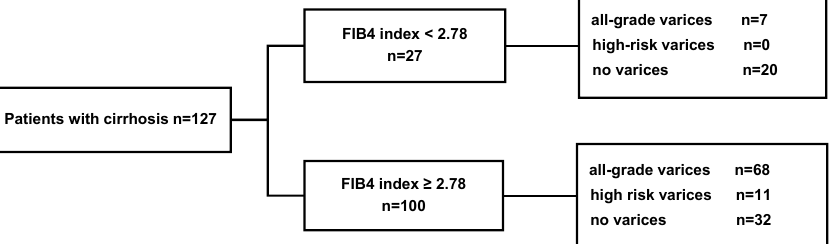
Figure 2. Rates of all-grade varices and high-risk varices according to a FIB-4 cuto ff of 2.78 in the estimation cohort of patients with cirrhosis. EV, esophagealvarices; FIB-4, fibrosis index based on four factors.